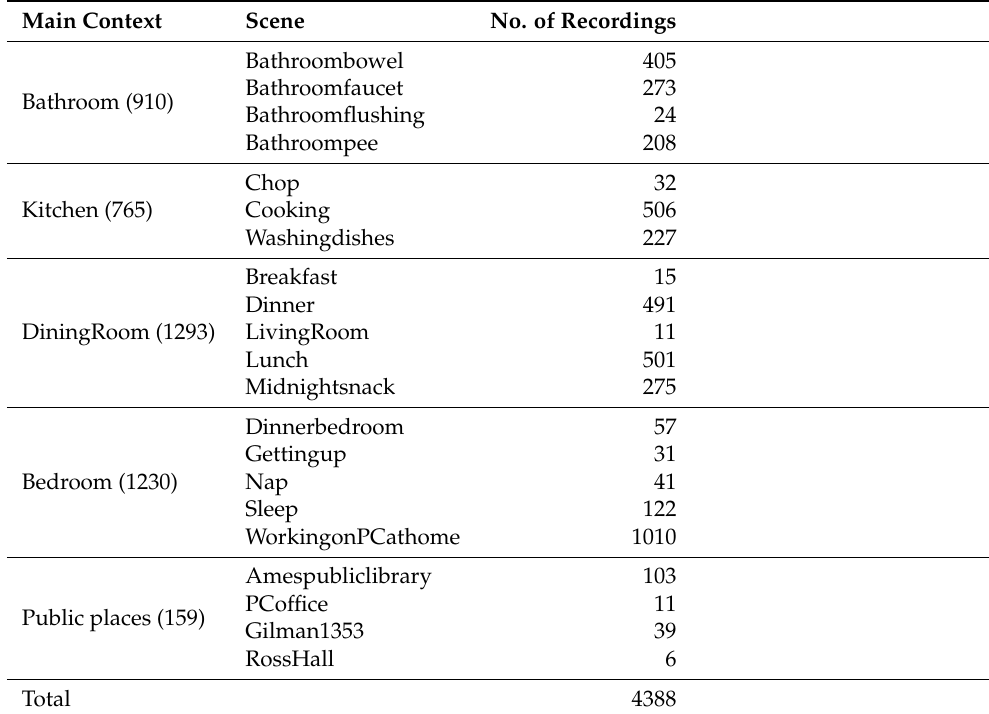
Table 2. List of the recorded ADL scenes, and number of recording for